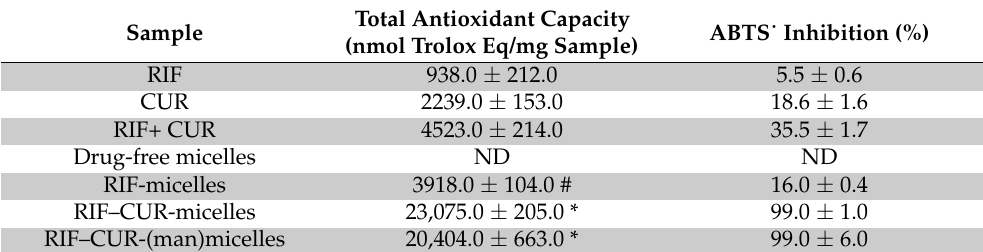
Table 5. Antioxidant activity of nanoformulations (drug-free, RIF-micelles, RIF–CUR-micelles and RIF–CUR-(man)micelles) and drugs dispersion (CUR, RIF and RIF + CUR), calculated as the inhibition percentage of ABTS radical. Data are expressed as mean ± S.D. (n =